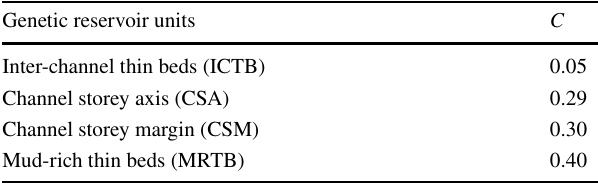
Fig. 20 Measured capillary pressure (black) and NMR capillary pres- sure (red) for the channel storey axis unit indicating a closer match between the entry pressures with much discrepancy with saturation ( S wirr ). The semi-log plot (below) scales the plot for better estimates of entry/displacement pressures